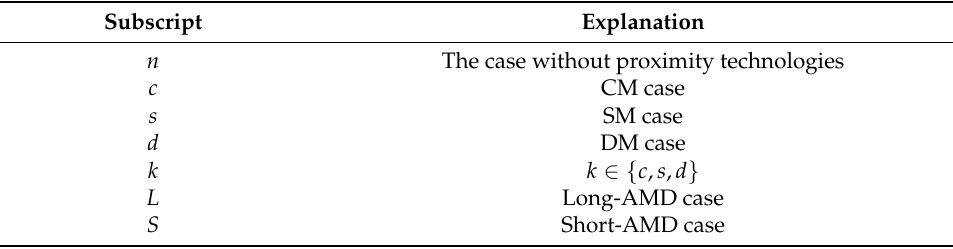
Table 2. Explanations of the